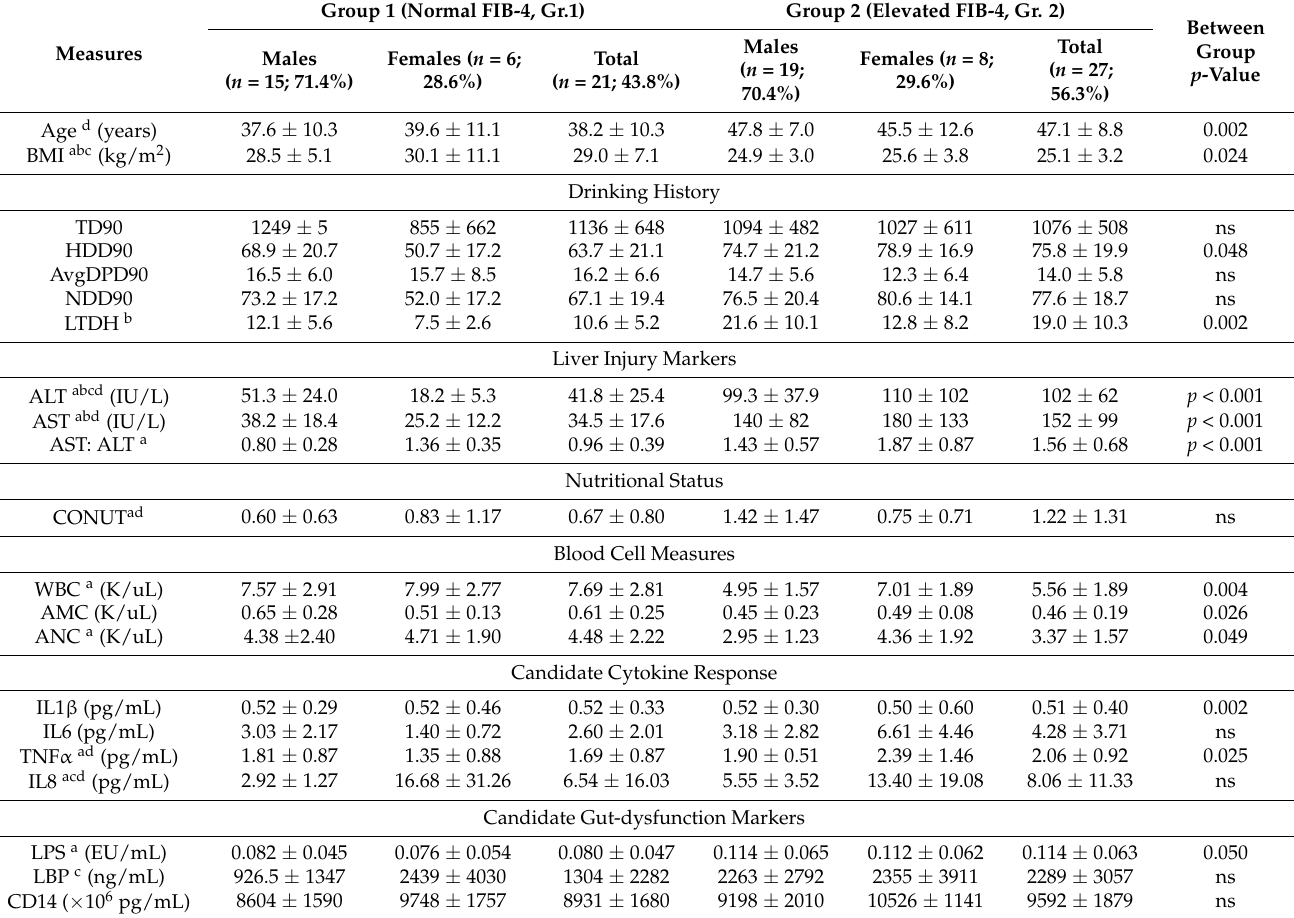
Table 1. Baseline demographics, drinking history, liver injury measures, nutritional status, candidate blood panel measures, cytokines, gut dysfunction markers, and cell death markers of the alcohol use disorder patients tabulated by FIB-4 present/absent